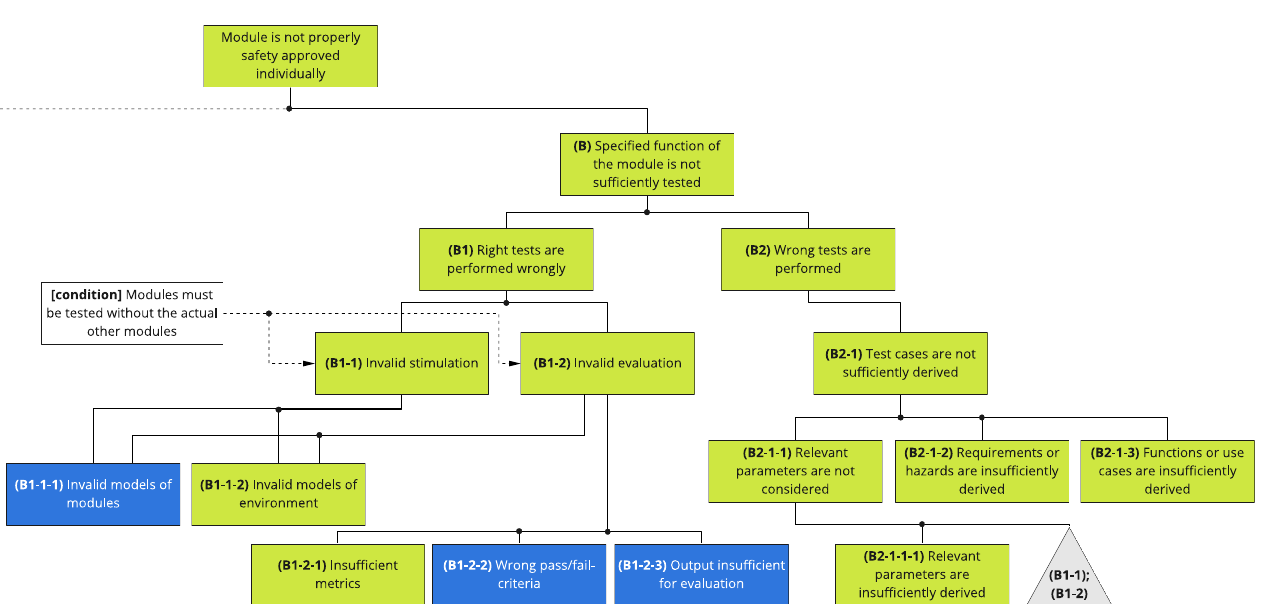
Figure 7. Fault tree of error B. Green boxes represent errors found by fault tree analysis. Blue boxes represent errors found by additional analysis of the test bench or test process. The grey triangle is referring to errors that were already introduced in the fault tree, but are also a cause for error B2-1-1. Dashed lines refer conditions for which the errors apply.